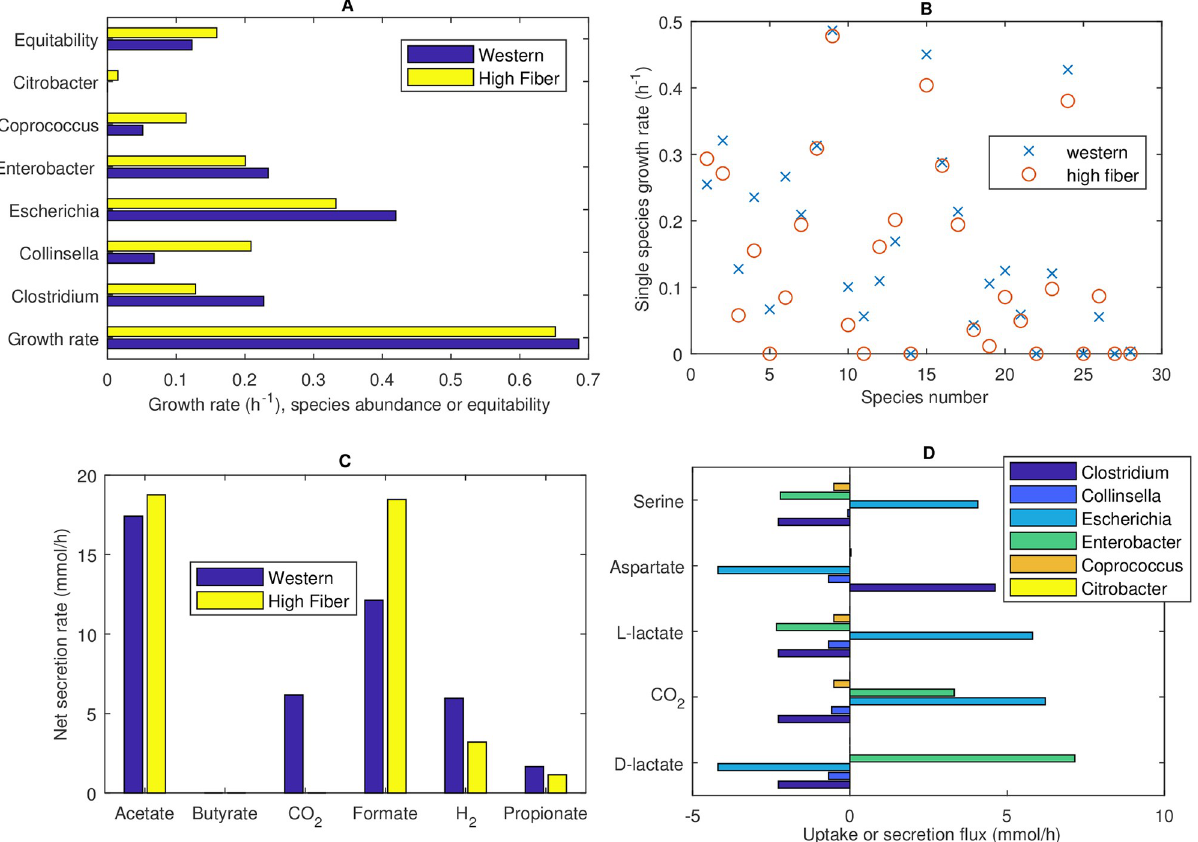
Fig 2. Optimized 28-species communities for in silico Western and high-fiber diets. (A) Growth rate (h − 1 ), non-zero species abundances and equitability measure D . (B) Single-species growth rates (h − 1 ) with species numbers corresponding to Table 1. (C) Net synthesis rates of major com metabolic byproducts including the three SCFAs acetate, butyrate and propionate. The byproducts ethanol, D-lactate, L-lactate and succinate are not shown because their net secretion rates were zero. (D) Uptake and secretion fluxes of the five metabolites most significantly crossfed between the participating species for the Western diet.